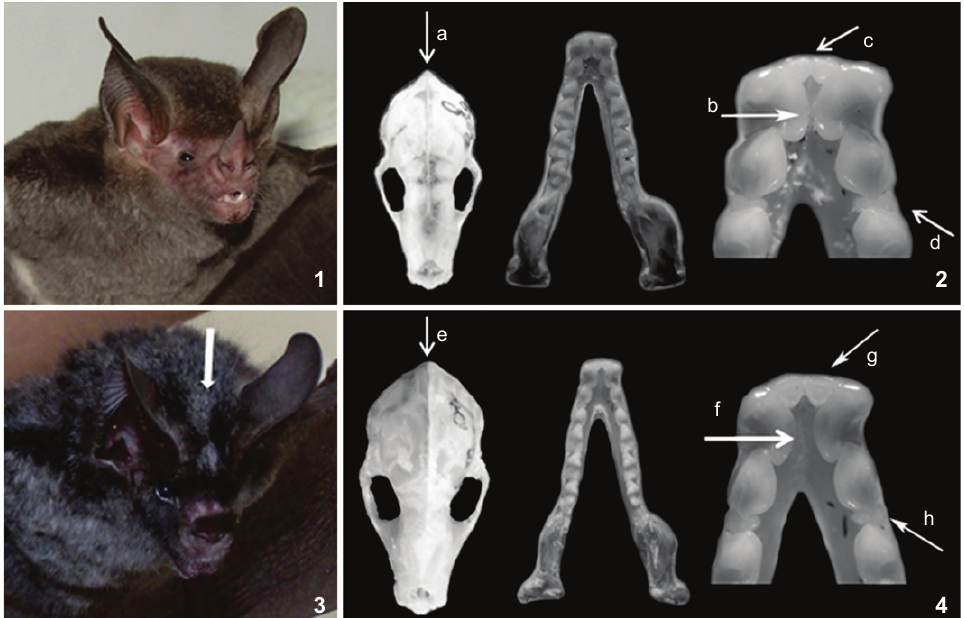
Figures 1-4. (1) T. bidens (RM 338); (2) cranium (left), mandible (center) and lower dentition of (right) T. bidens : (a) broad post-orbital constriction, (b) narrow opening separating the lower canines, (c) narrow lower incisors, and d) agglomeration of the second lower premolar; (3) T. saurophila (RM 354), showing the distinct white stripe on the top of the head (arrow); (4) cranium (left), mandible (center) and lower dentition (right) of T. saurophila : (e) post-orbital constriction less evident, (f) lower canines separated by a relatively wide space, (g) relatively broad lower incisors, and (h) second lower premolar more robust and less